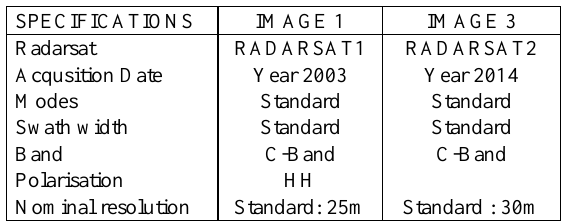
Table 1 : Detail specification of RADAR imageries used in